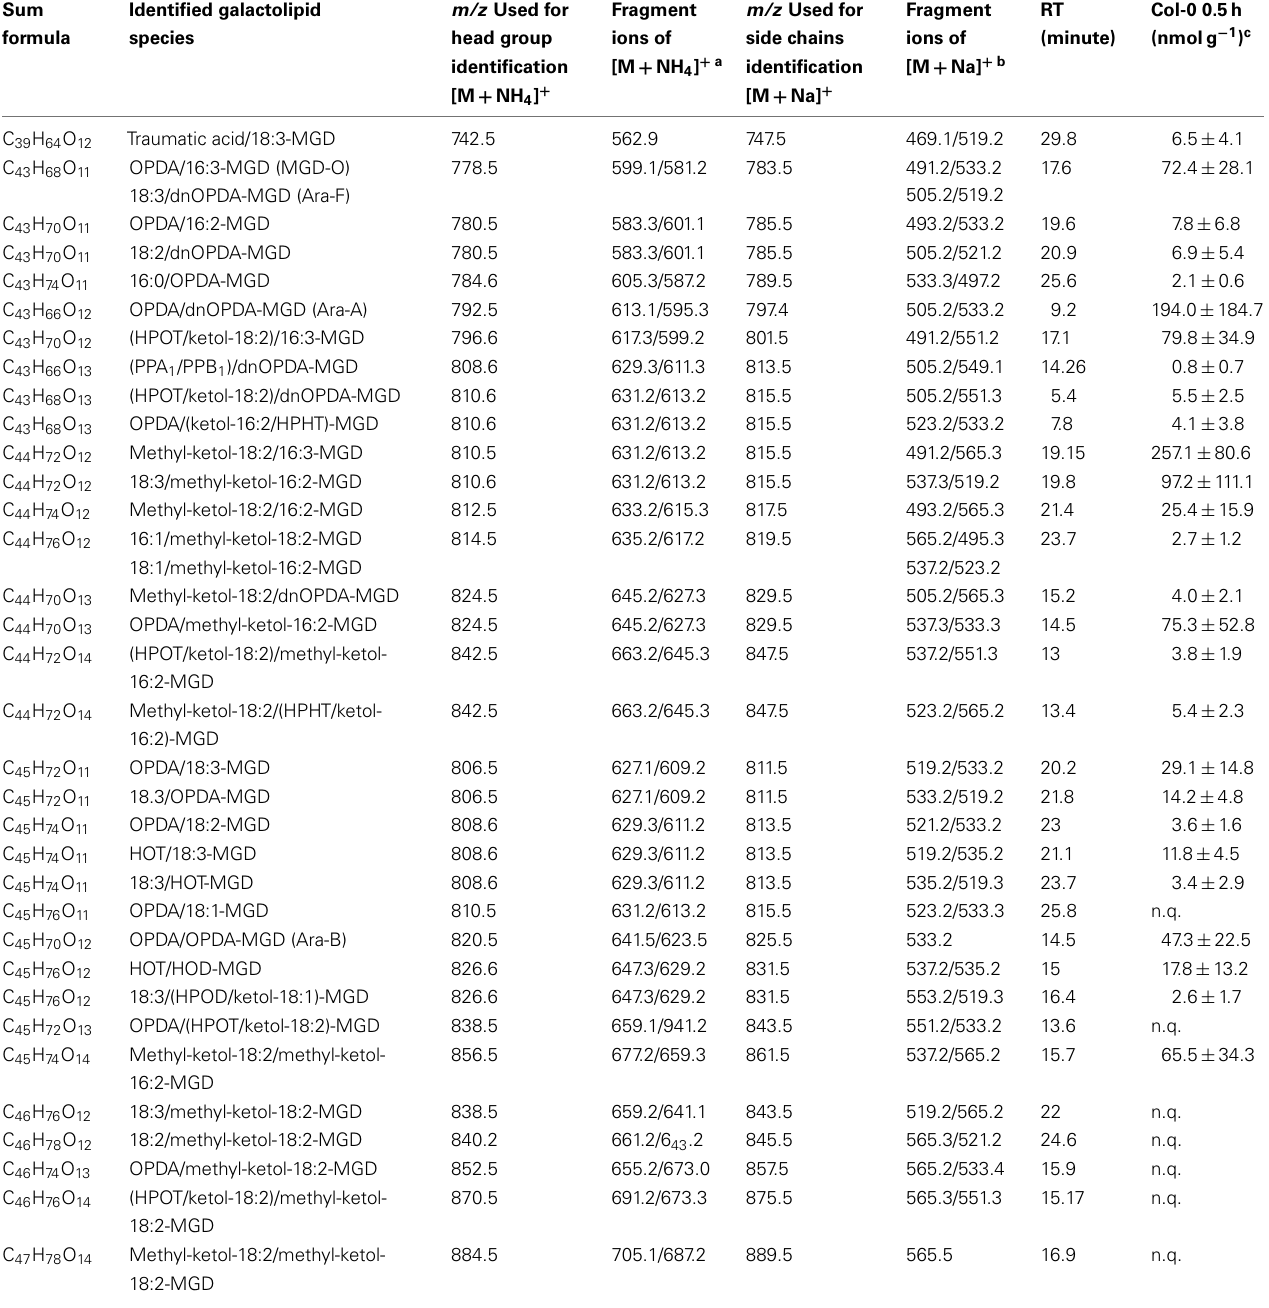
TableA2 | Oxidized MGD species identified in wounded A. thaliana